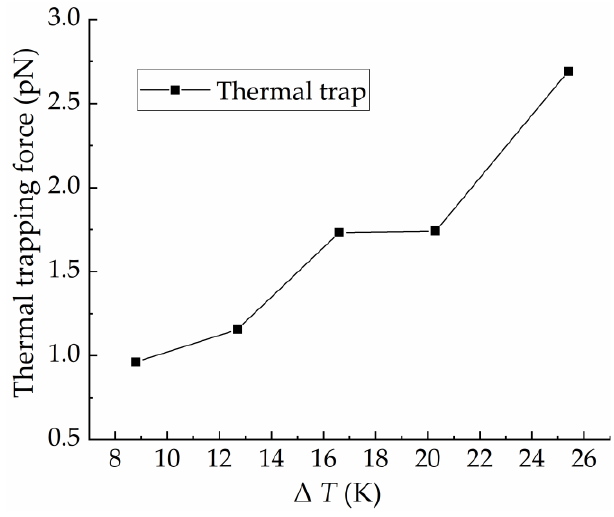
Figure 4. Thermal trapping force F t of the optothermal trap close to a gold film.